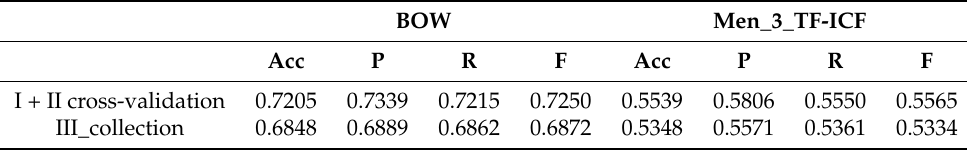
Table 4. Performance of the classifier with the I + II joint collection added to the training collection.